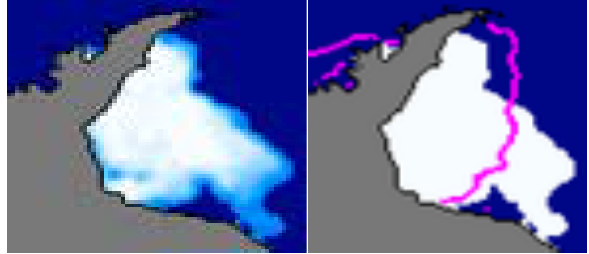
Fig. 6. Average ice coverage (left) and extent (right) for February 2009, together with the median ice